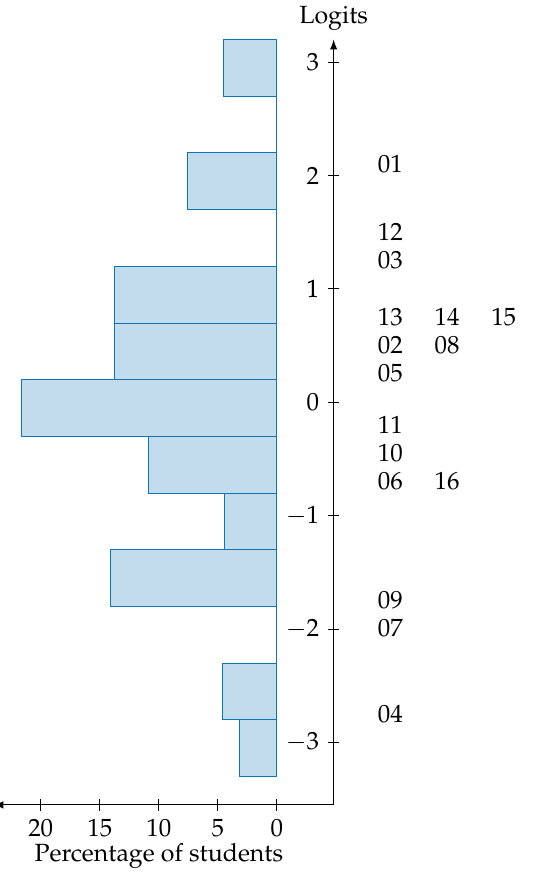
Figure 3. Wright Map of our concept inventory. The left-hand side represent the frequency of respondents’ latent trait levels within the sample. The right-hand side represents a hierarchical order of all items along the logit